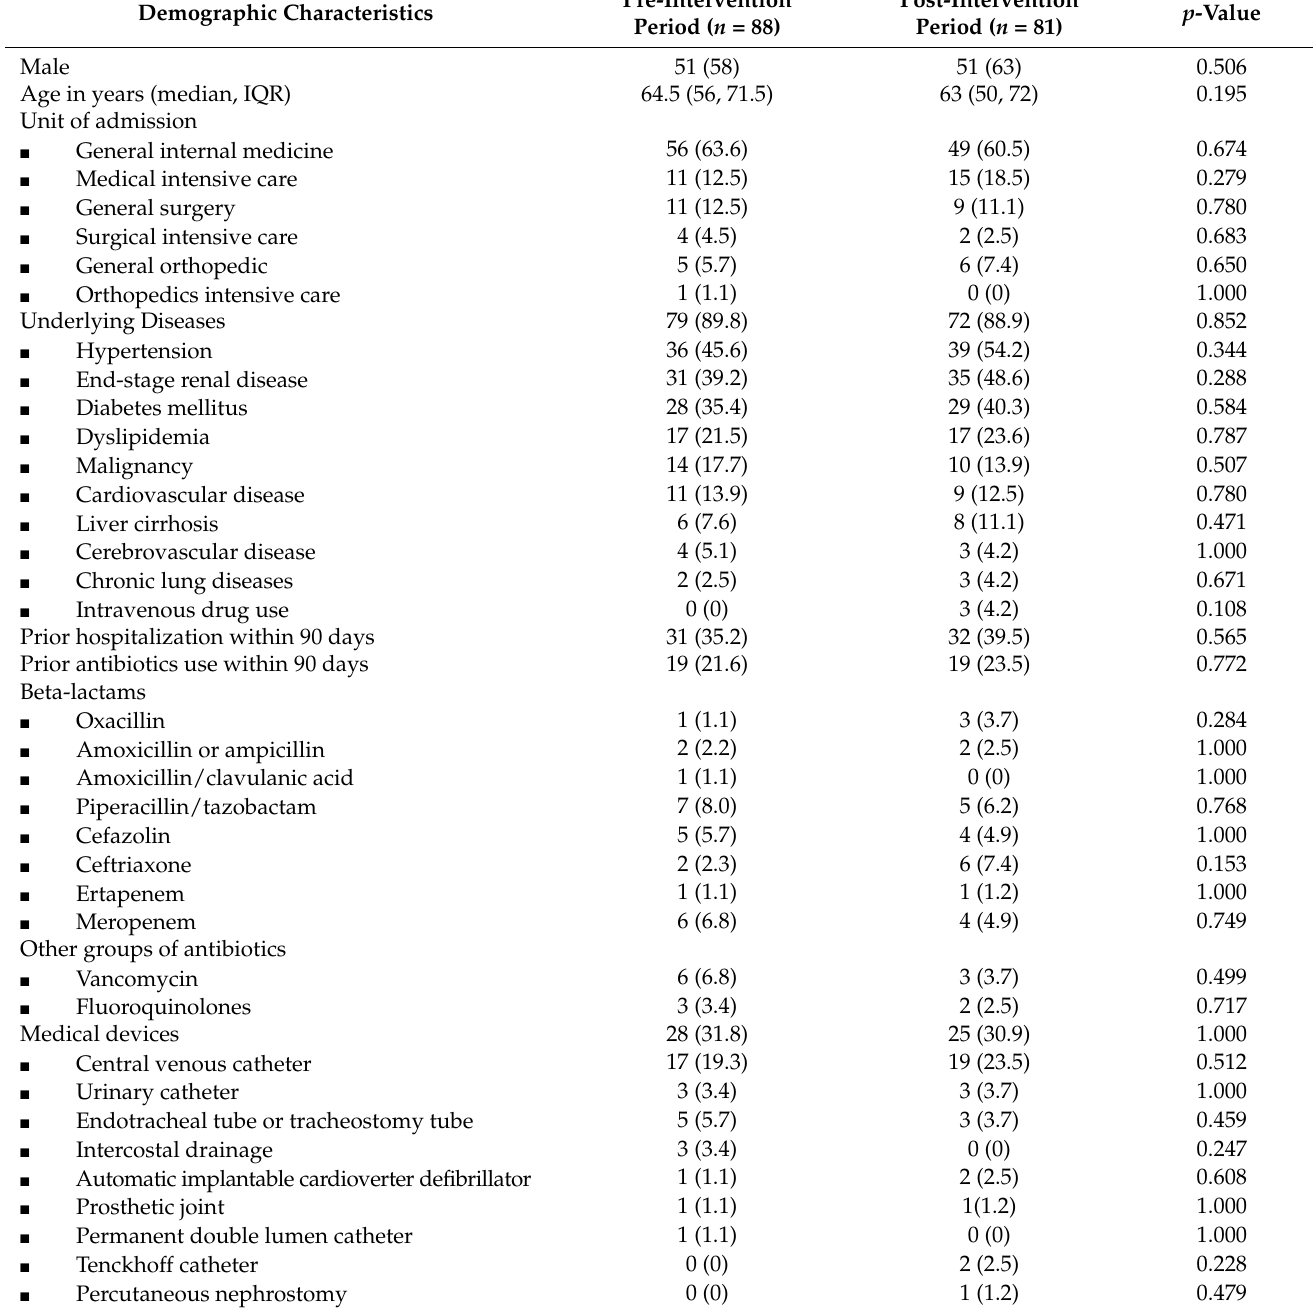
Table 1. Demographic characteristics of patients who had Staphylococcus aureus bloodstream infections. Demographic